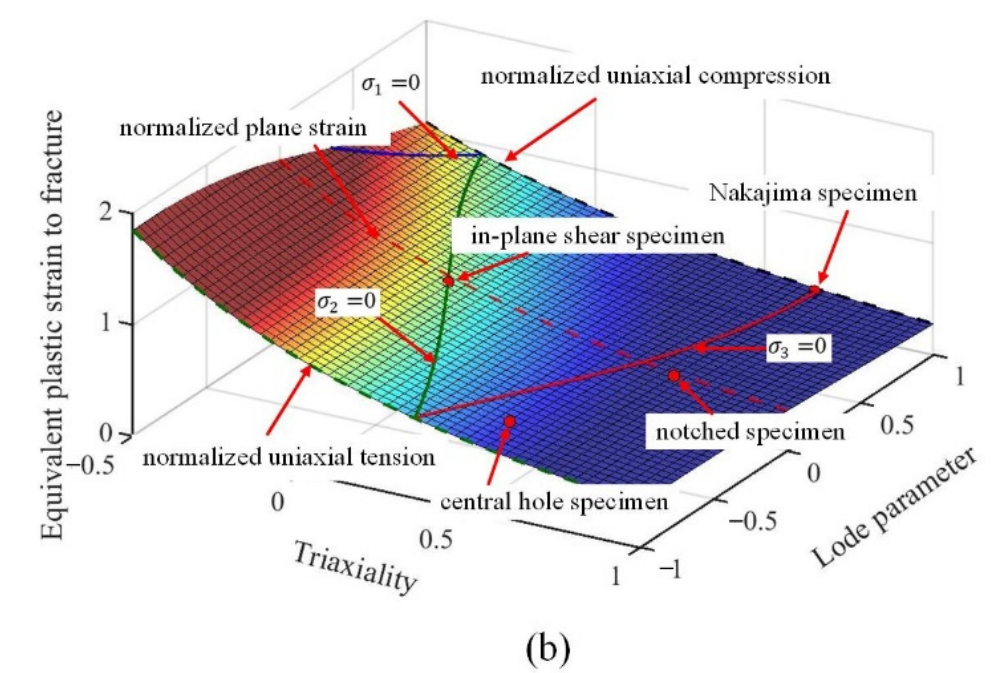
Figure 15. The constructed fracture loci optimized according to the predicted fracture strain in varying stress states and compared with experimental data: ( a ) bainite; ( b ) martensite.